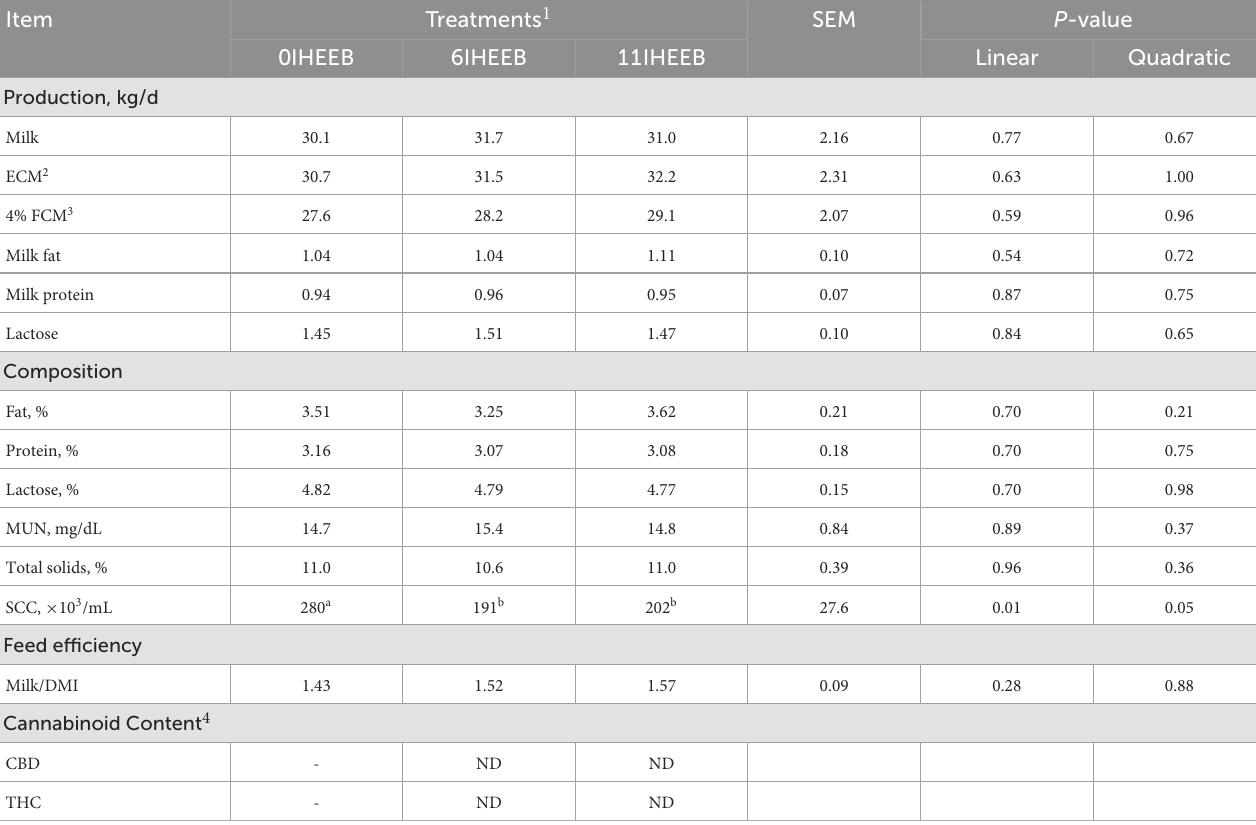
TABLE 4 Milk production, milk composition, and feed efficiency in Holstein cows fed the 3